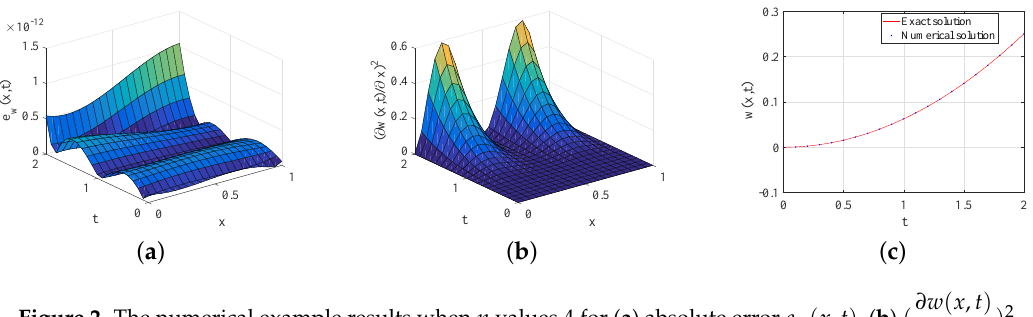
Figure 2. The numerical example results when n values 4 for ( a ) absolute error e w ( x , t ) , ( b ) ( and ( c ) comparison of exact solution and numerical